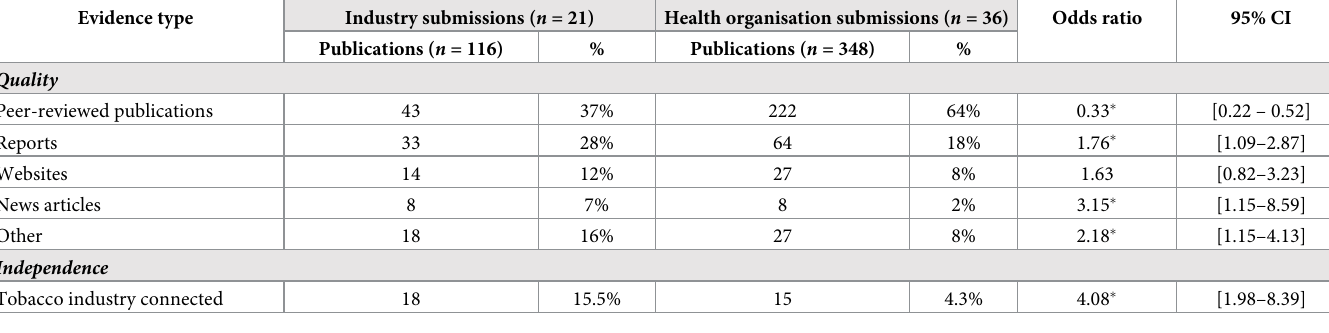
Table 2. Publications cited in submissions by Industry and health organisations. Evidence